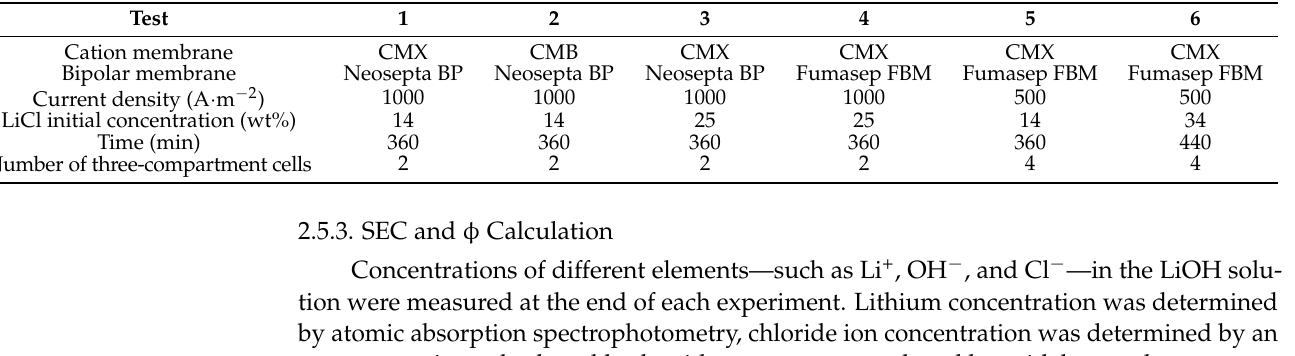
Table 5. Operating conditions of long-running tests of LiOH production according to different bipolar membranes, initial LiCl concentration, and current density.